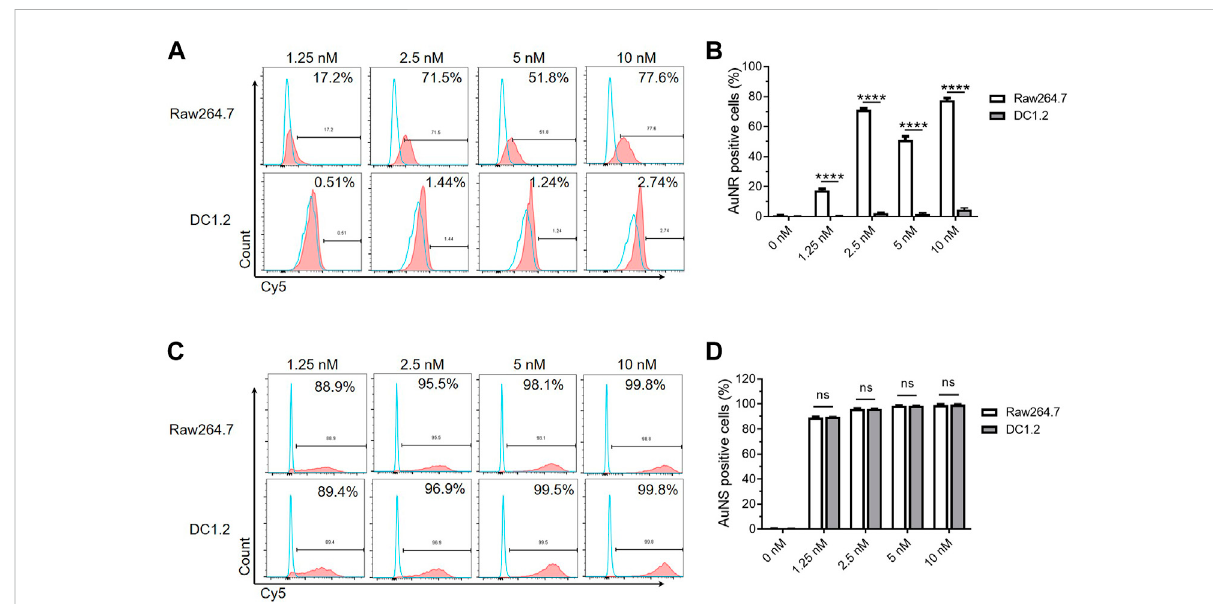
FIGURE 3 The macrophages and DCs cultured in vitro are not suitable for studying the interactions between nanoparticles and TIMs and TIDCs. (A) Flow cytometryanalysesofAuNRaccumulationinDC1.2andRaw264.7celllines( n =3).TheconcentrationofAunanoparticleswas1.25 nM,2.5 nM,5 nM and 10 nM. (B) Frequencies of AuNR positive cells in DC1.2 and Raw264.7 cell lines 2 h after AuNR challenge at 37 ° C ( n = 3). (C) Flow cytometry analyses of AuNS accumulation in DC1.2 and Raw264.7 cell lines ( n = 3). The concentration of Au nanoparticles was 1.25 nM, 2.5 nM, 5 nM and 10 nM. (D) Frequencies of AuNS positive cells in DC1.2 and Raw264.7 cell lines 2 h after AuNS challenge at 37 ° C ( n = 3). **** p <